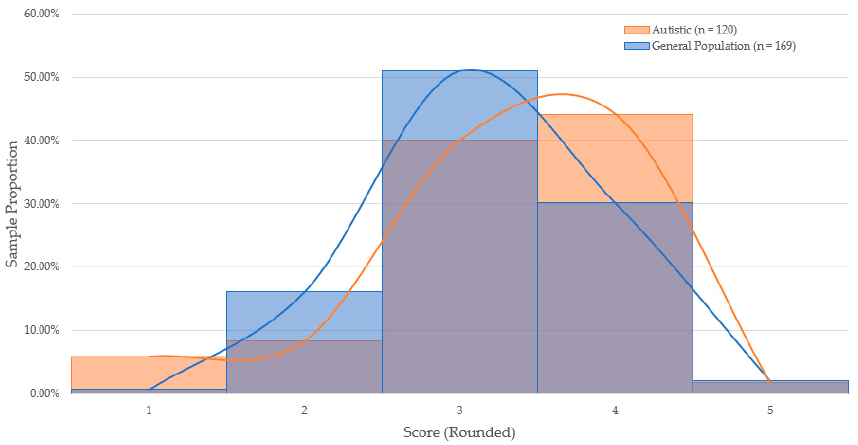
Figure 1. Distribution of Performance on Disconumbers & Shapedance by Sample Proportion.